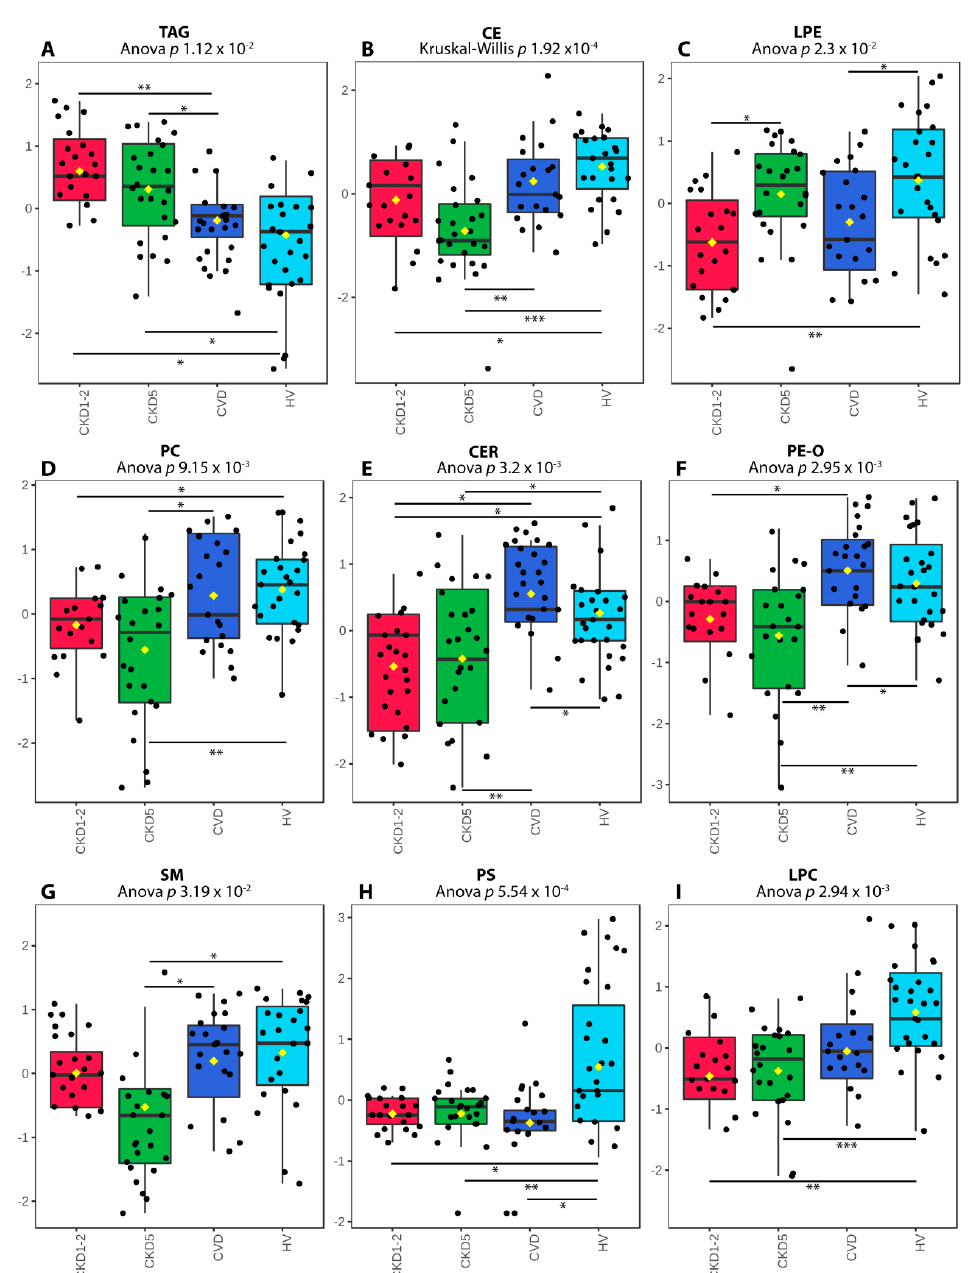
Figure 2. Differentially accumulated lipid classes sorted according to Anova/Kruskal–Wallis p -values: ( A ) triacyloglycerols (TAG). ( B ) cholesterol and cholesterol esters (CE). ( C ) lysophosphatidylcholines (LPE). ( D ) phosphatidylcholines (PC). ( E ) ceramides (CER). ( F ) phosphatidylethanolamines (PE-O). ( G ) sphingomyelins (SM). ( H ) phosphatidylserines (PS). ( I ) lysophosphatidylcholines (LPC). A box on a plot presents interquartile ranges and medians. The black dots correspond to the normalized accumulation of lipid classes in all samples. The notch indicates the 95% confidence interval around the median of each group. The mean level is indicated with a yellow diamond. Bars and asterisks show the results of U-Mann–Whitney/ t -test: * p < 0.05, ** p < 0.01, *** p < 0.001; n = 25 in each